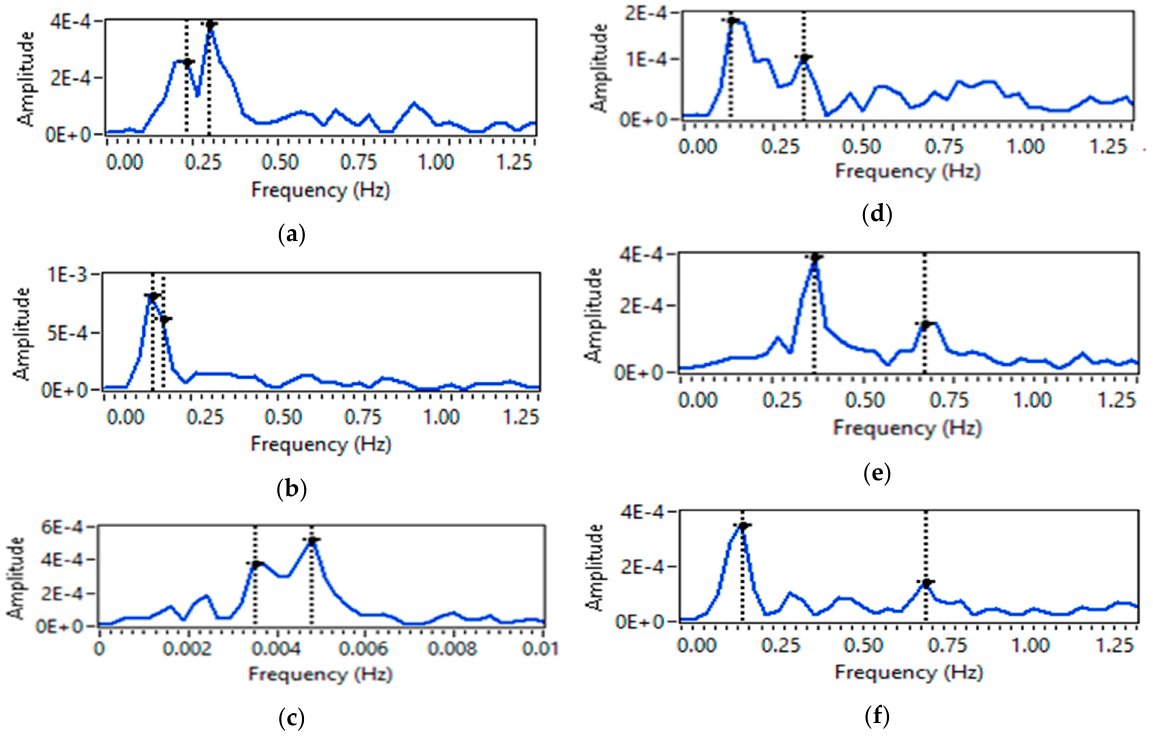
Figure 10. Breathing rate extraction for two persons-scenario: ( a ) normal-normal; ( b ) slow-slow; ( c ) fast-fast; ( d ) normal-slow; ( e ) normal-fast; and ( f ) slow-fast.